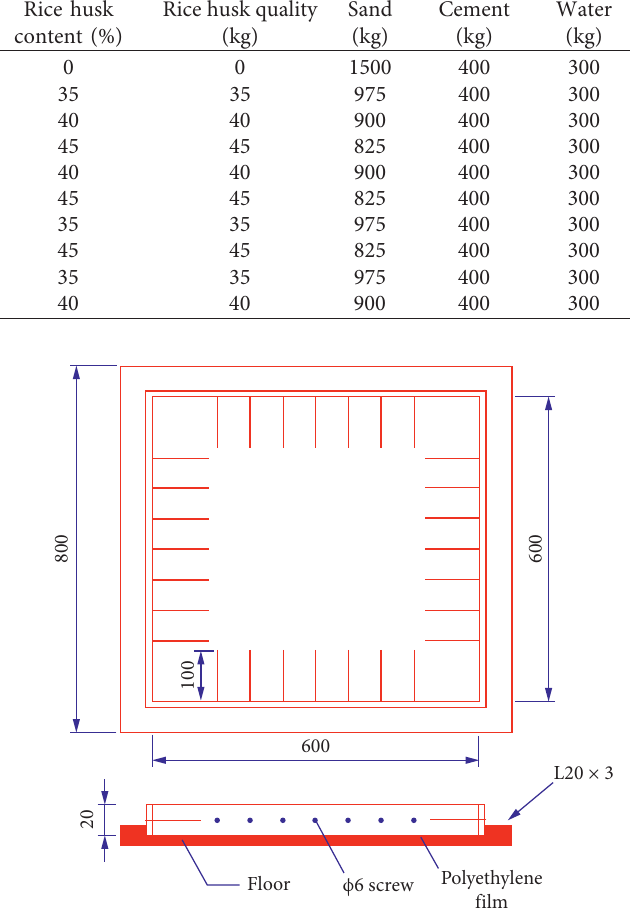
Figure 3: Test mold of early plastic shrinkage